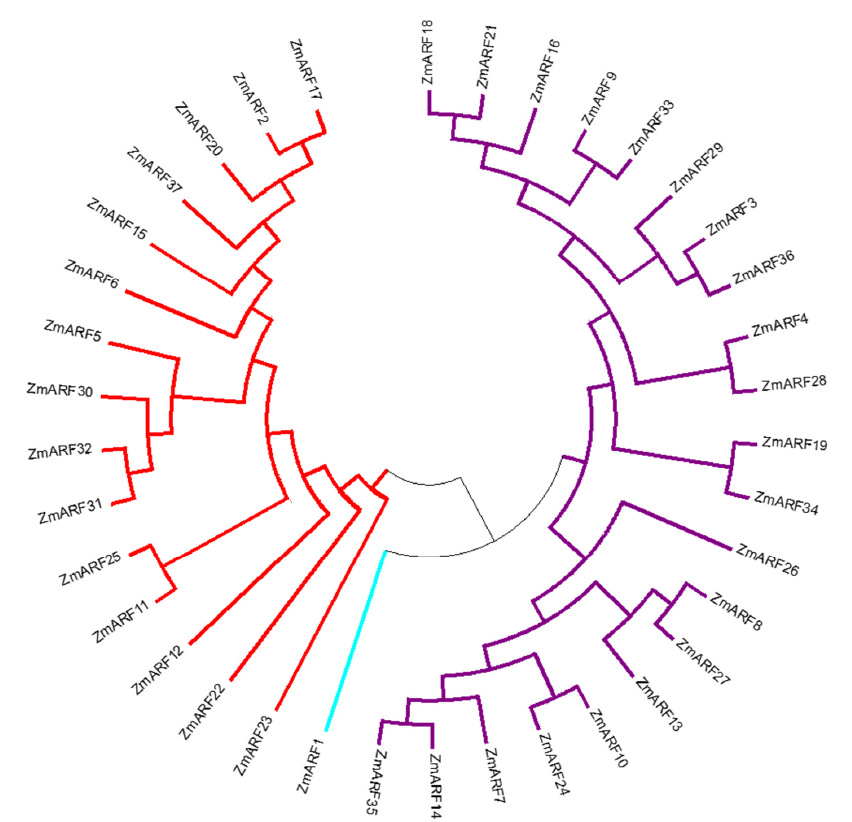
Figure 1. Phylogenetic tree of maize ARF genes. The unrooted tree was generated using the MEGA v7.0 program with the Neighbor-Joining method. All thirty-eight maize ARFs were classified into three groups